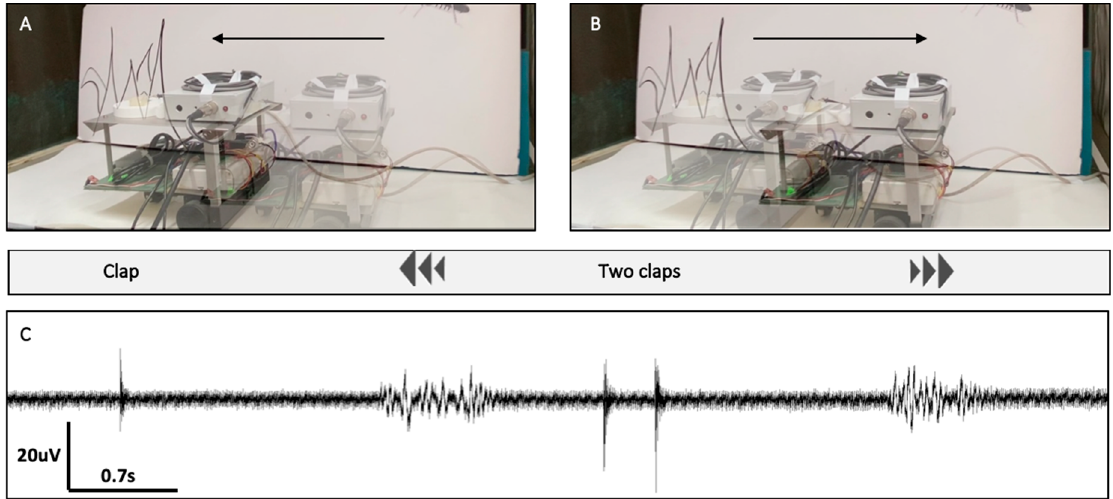
Figure 5. Hybrid Bio-Robotic-Sensing system. ( A ) The Ear-Bot moves forward as a response to one clap and ( B ) backward as a response to two claps. ( C ) The Ear-Chip electrophysiological response to the claps.